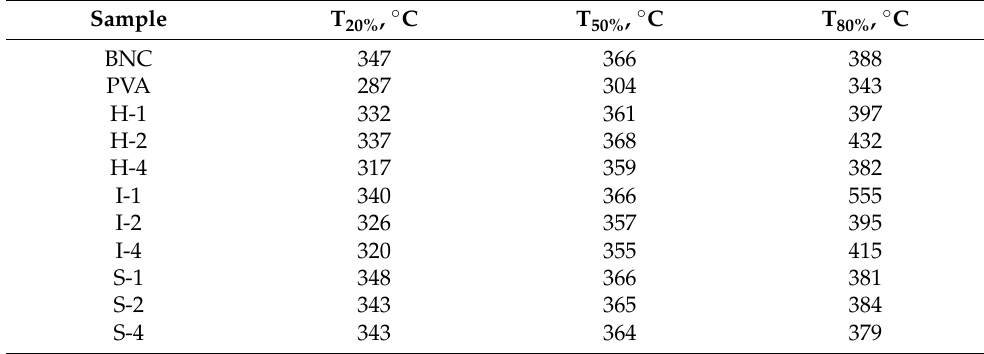
Table 6. The temperatures corresponding to the weight losses of 20%, 50%, and 80% determined from TG